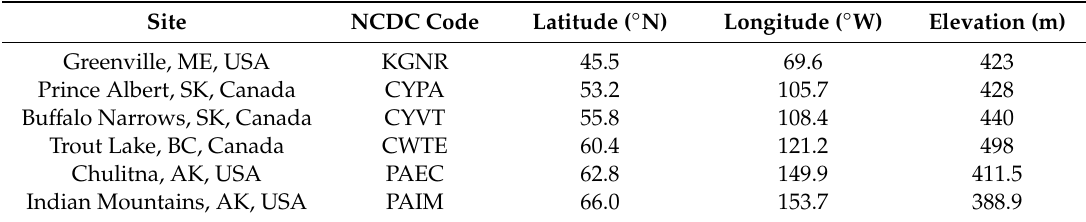
Figure 1. Spatial distribution of white spruce in North America. The six locations considered for analyses (see Table 1) are also identified (image has been modified based on the original map from www.usgs.gov). Table 1. Geography of the study